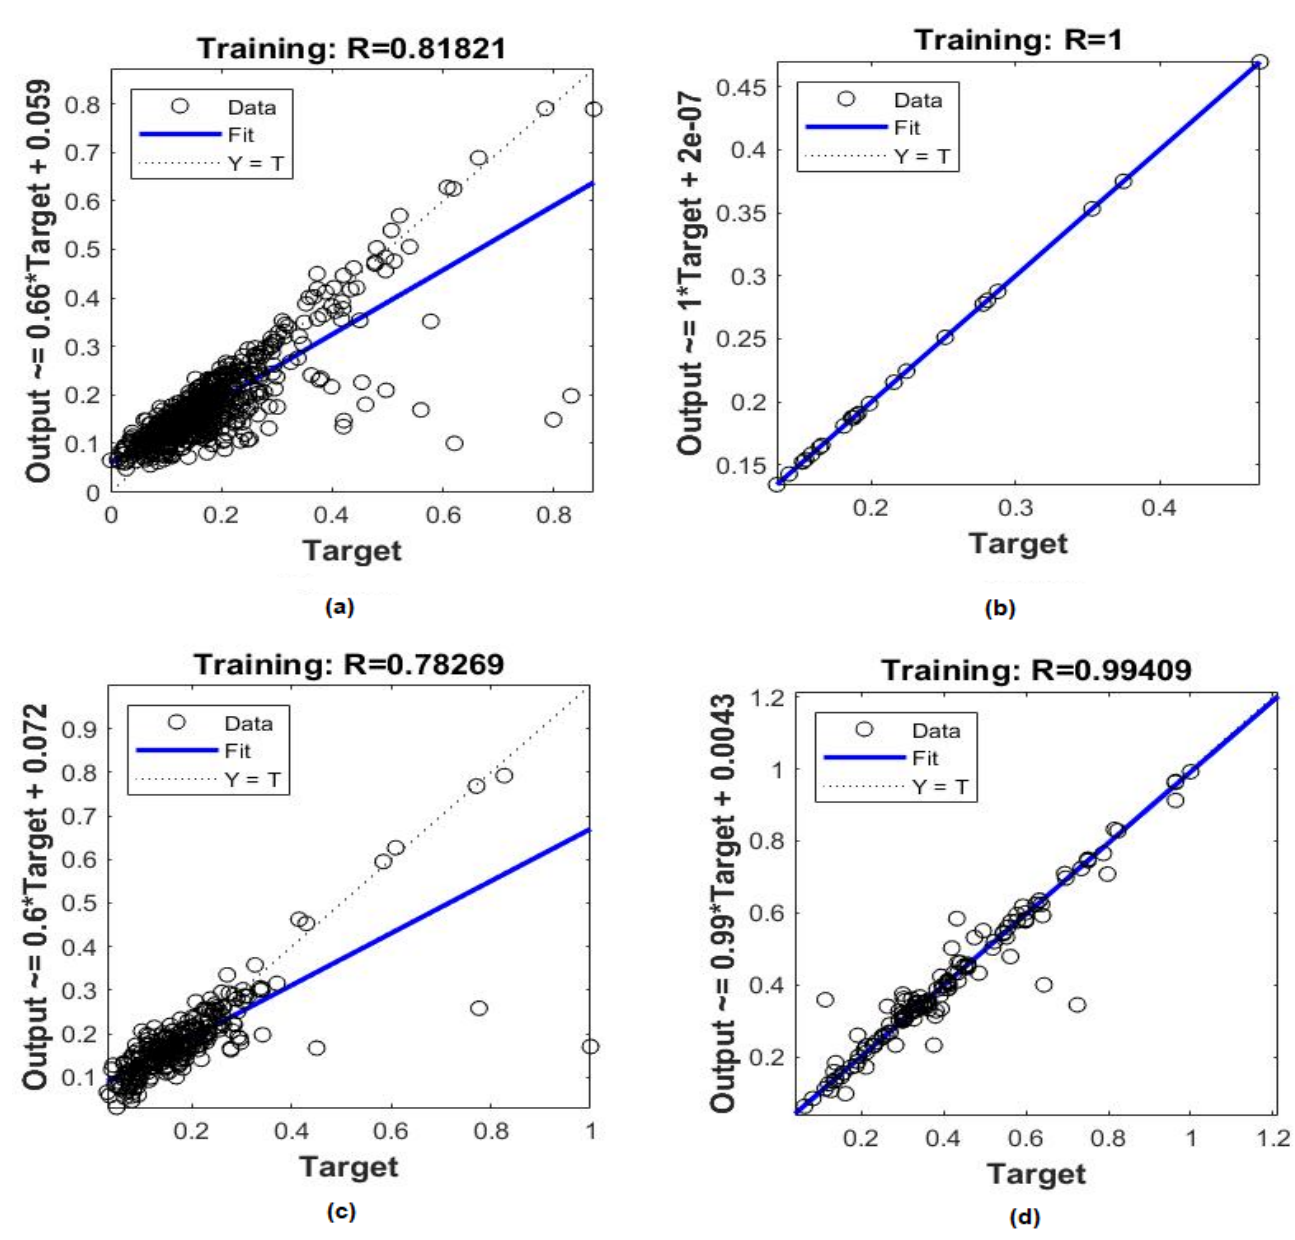
Figure 7. Regression plot of ANN model for predicting house price at the training phase: ( a ) Riyadh, ( b ) Dammam, ( c ) Jeddah, and ( d ) Al-Khobar.